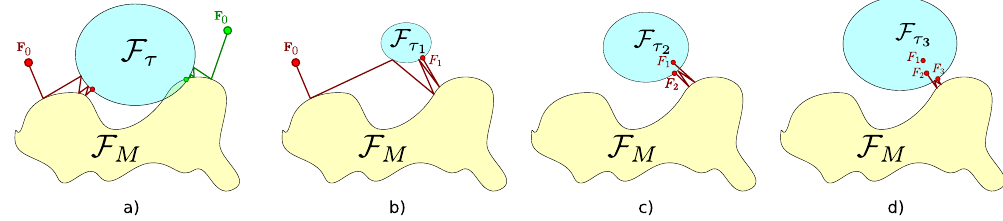
Figure 5. Scheme of the alternate projections. ( a ) the choice of a wrong starting point ( red ) can lead to local minima; the choice of a good starting point ( green ) can lead to a solution; ( b ) if τ is too small, there could be no intersection of sets; and ( c,d ) smoothly increasing the value of τ allows for moving towards the solution of the starting